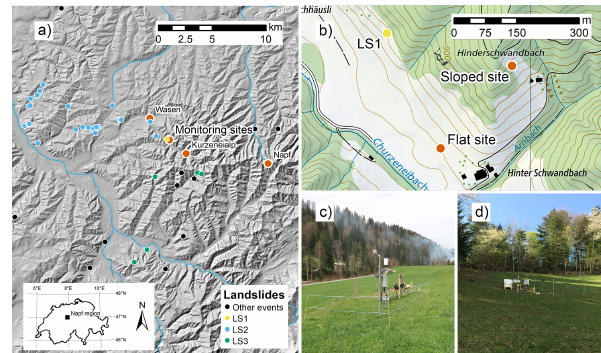
Figure 1. (a) Hillshade extract of the Napf region showing the lo- cations of the soil wetness monitoring sites (“monitoring sites”), as well as the meteorological sites Wasen, Kurzeneialp, and Napf with orange dots. Further, the locations of landslides that occurred during the study period are shown with yellow, blue, and green dots corresponding to the landslide events LS1, LS2, and LS3 (see Sect. 2.4), respectively, and black dots corresponding to all other landslide events (some landslide events included in this study oc- curred outside the map extract). (b) Topographic map extract show- ing the locations of the sloped and the flat site and photos of the flat (c) and sloped site (d) (copyright by Federal Office of Topography swisstopo, Wabern,